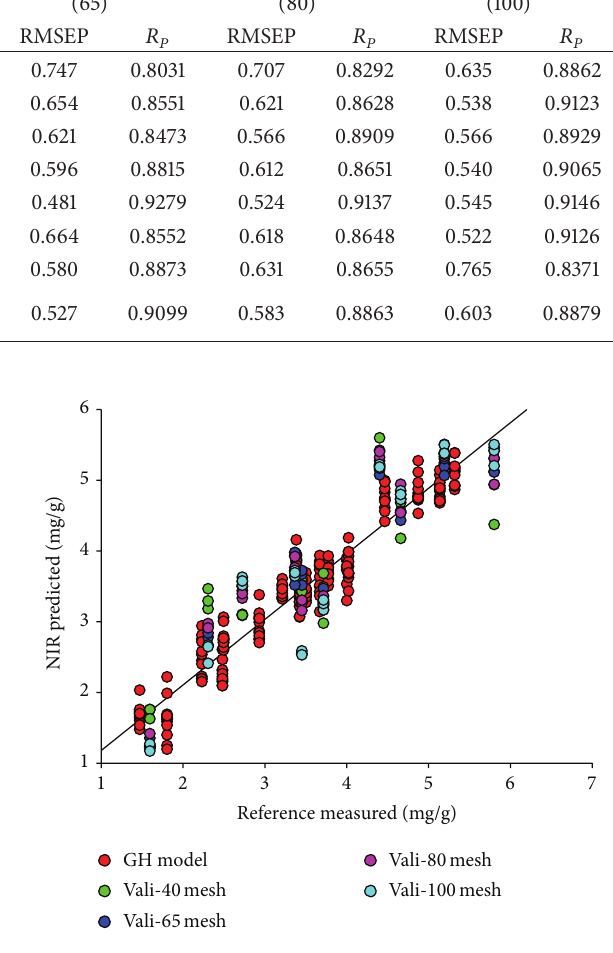
Figure 5: Correlation diagrams of GH